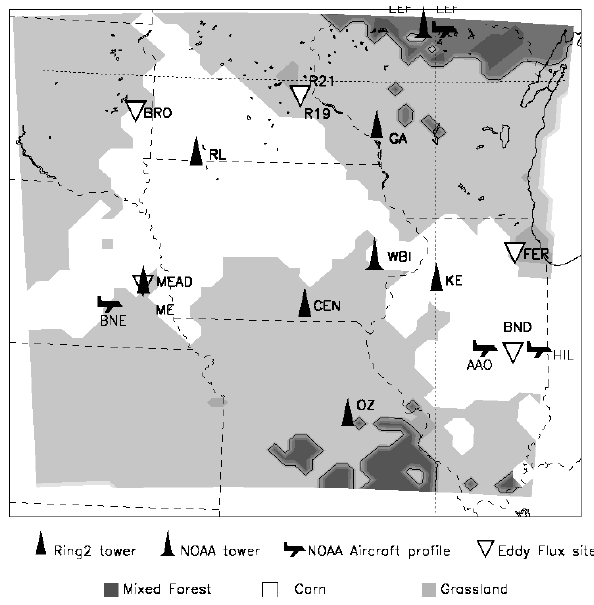
Fig. 1. The Mid Continent Intensive domain with the dominant plant functional types and the observation locations including the concentration tower sites used in the inversion (Ring2 and NOAA towers), the boundary conditions (NOAA aircraft profiles), and the eddy-flux sites used to evaluate the posterior